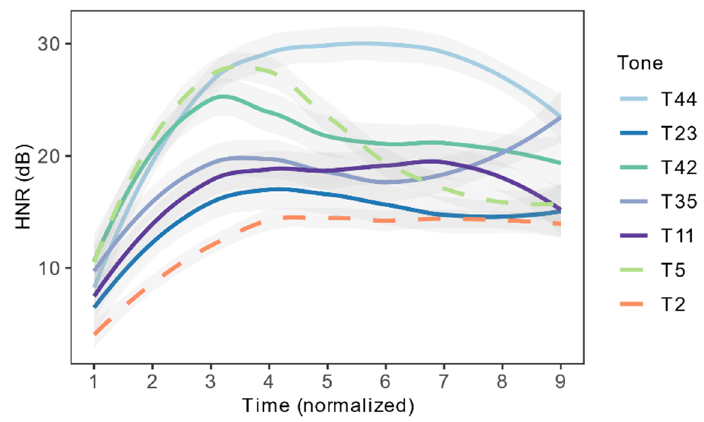
of the HNR contour at P4.